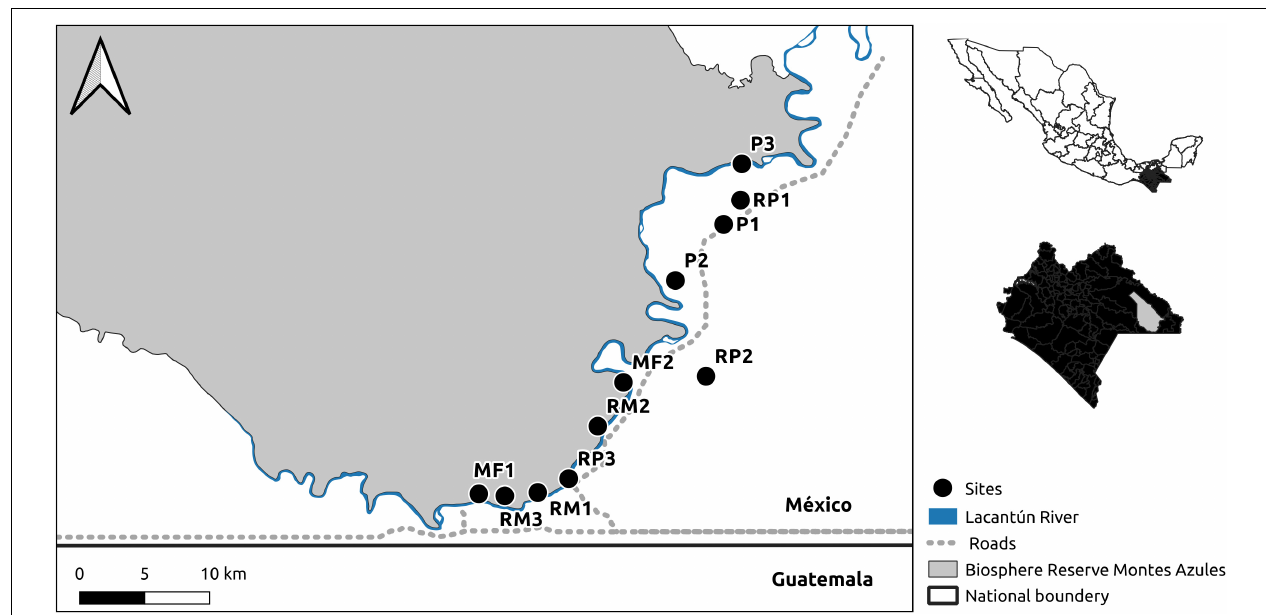
FIGURE 1 | Study area and bat sampling sites at the Lacandona rain forest, Chiapas, Mexico. The map shows the distribution of the habitat types used to sample bat species: riparian vegetation in mature forest (RM), riparian vegetation in pasture (RP), mature forest (MF), Pasture